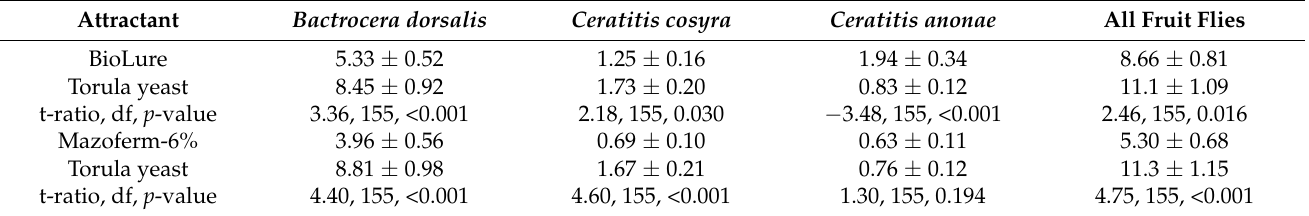
Table 5. Comparison of fruit fly responses (means ± SE flies/trap/week) to BioLure vs. Torula yeast, and Mazoferm vs. Torula yeast, in the Nkolbisson orchard (humid forest with bimodal rainfall). Ceratitis cosyra All Fruit